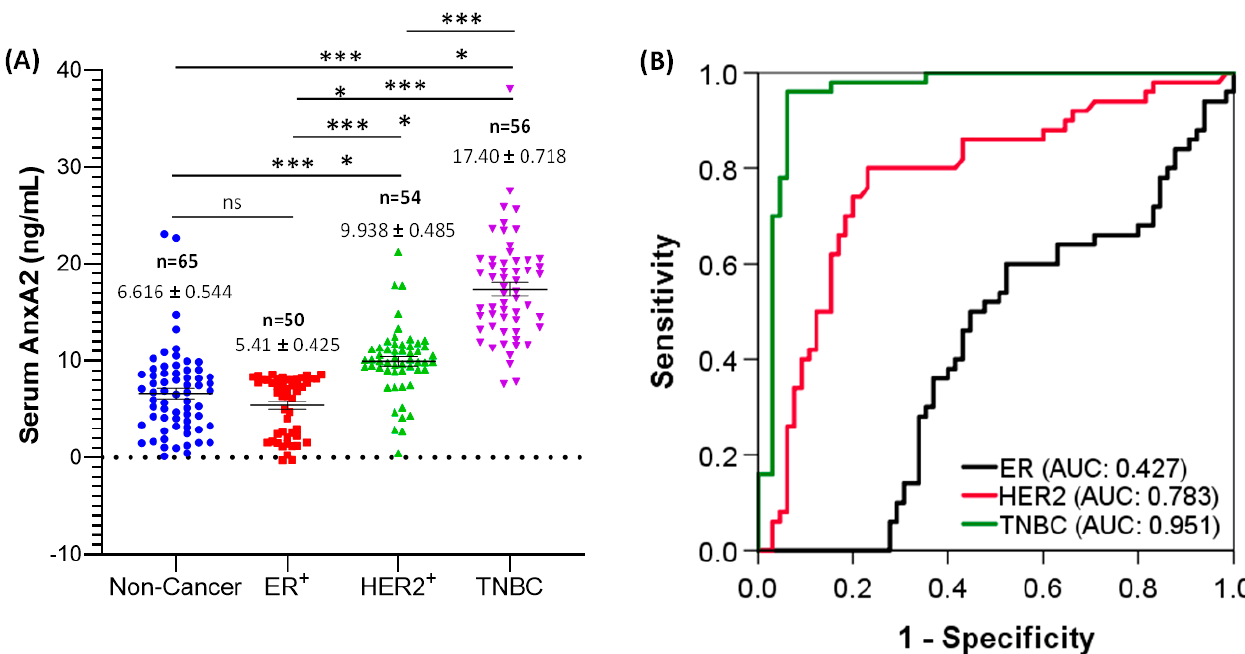
Figure 3. Serum AnxA2 levels in breast cancer subtypes. ( A ) Serum AnxA2 expression in normal healthy females ( n = 65), ER + ( n = 50), HER2 + ( n = 54), and TNBC ( n = 56) breast cancer patients. The data are presented as the mean ± SEM (****, p < 0.0001; one-way ANOVA followed by Tukey multiple comparison test). ( B ) ROC curves for ER + ( n = 50), HER2 + ( n = 54) and TNBC ( n = 56) patients versus normal healthy females ( n = 65).